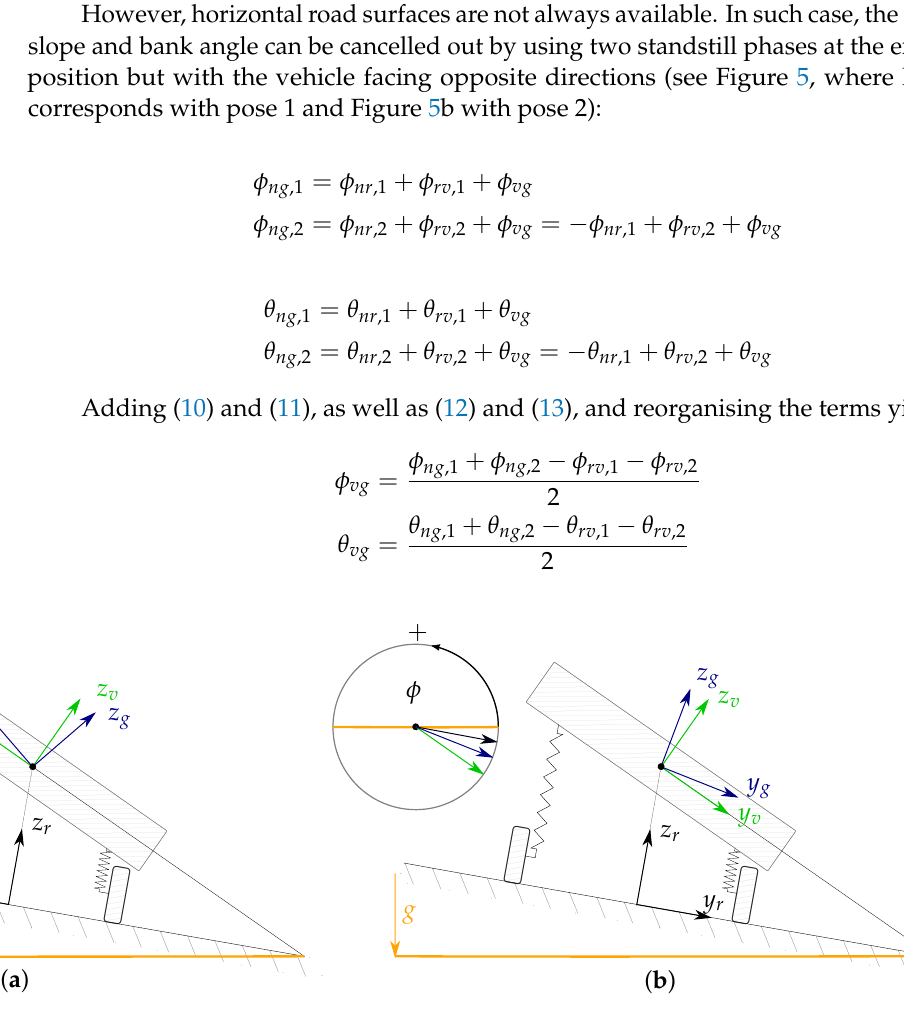
Figure 5. Calibration procedure on non-horizontal road (roll angle perspective). ( a ) depicts the first standstill pose and ( b ) the second, which is equal to the first pose but facing the opposite direction. g , v and r denote the ground-truth, vehicle and road coordinate systems, respectively. ( a , b ) correspond with (10) and (11), respectively. The yellow line represents the horizontal plane. The circle on the upper left shows the direction of positive roll angles, and the arrows in it represent the y -axes of the corresponding coordinate systems. Note that, in the circles, the angle between the yellow line and the black arrow correspond with φ nr . It can then be seen that φ nr ,2 = − φ nr ,1 . The corresponding pitch angle perspective would be equivalent. It is omitted for the sake of